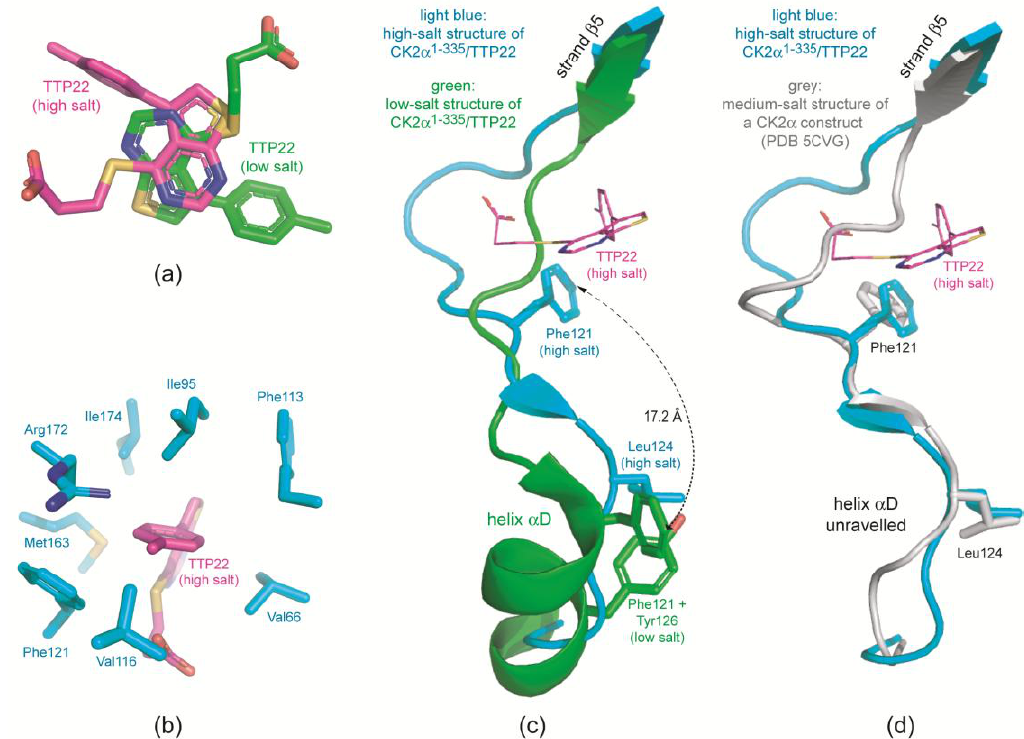
Figure 8. Structural differences between the high-salt and the low-salt CK2 α 1–335 /TTP22 complex. ( a ) The inhibitor TTP22 bound to CK2 α 1–335 under low-salt conditions (structure 5 of Table 1; magenta-coloured C -atoms) and under high-salt conditions (structure 6 of Table 1; green C -atoms) after superimposition of the protein matrices; ( b ) Cage of hydrophobic side chains or side chains with an aliphatic part (Arg172) surrounding the methylphenyl moiety of TTP22 under high-salt conditions; ( c ) Comparison of the hinge/helix α D region of the low-salt (green) and the high-salt (light blue) CK2 α 1–335 /TTP22 structure; ( d ) Comparison of the hinge/helix α D region of the high-salt CK2 α 1–335 /TTP22 structure (light blue) and a recently published medium-salt CK2 α structure with unraveled helix α D (PDB 5CVG [39]).